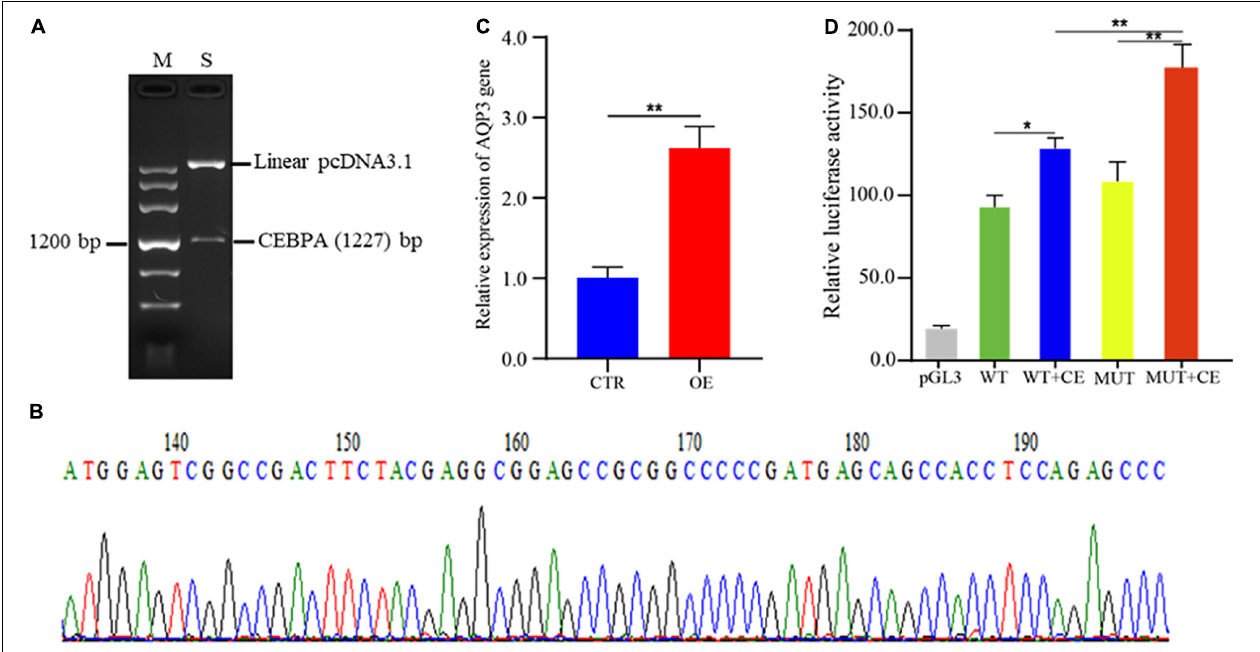
FIGURE 4 | Effects of transcription factor CEBPA on AQP3 expression. (A) Enzyme digested products of the plasmids overexpressing CEBPA. (B) PCR sequencing of the plasmids overexpressing CEBPA. (C) Overexpression of CEBPA enhances AQP3 expression. OE, CEBPA overexpression group; CTR, control group. (D) Effects of CEBPA overexpression on the transcriptional activity of AQP3 promoter constructs. pGL3, cells transfected with pGL3 plasmids; WT, cells transfected with AQP3 promoter constructs containing wild type sequences; WT + CE, cells co-transfected with AQP3 promoter constructs containing wild type sequences